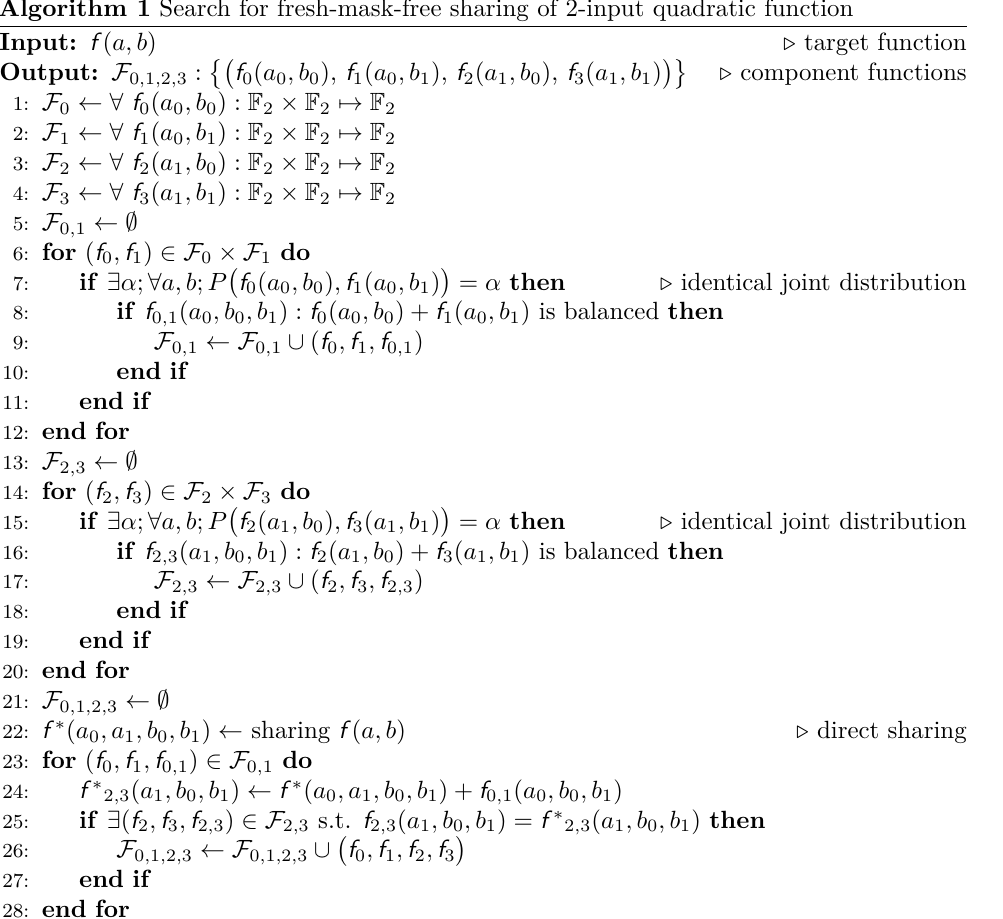
Algorithm 1 Search for fresh-mask-free sharing of 2-input quadratic function